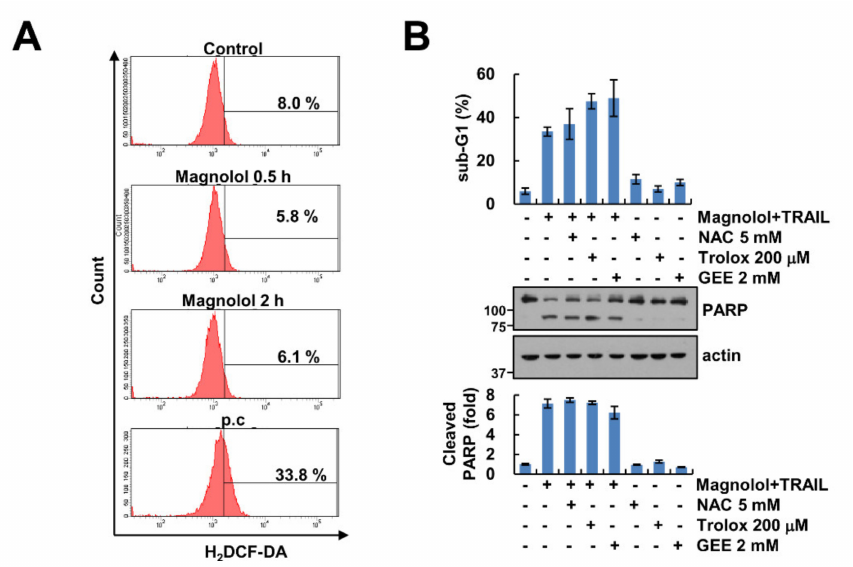
Figure 6. Involvement of ROS in magnolol plus TRAIL-induced apoptosis. ( A ) Caki-1 cells were treated with 10 µ M magnolol for 0.5 and 2 h. Thioridazine was used as positive control (p.c). Caki-1 cells were stained with H 2 DCF-DA dye. Fluorescence was detected using flow cytometry. ( B ) Caki-1 cells were treated with 10 µ M magnolol plus 50 ng / mL TRAIL in the presence or absence of 5 mM NAC, 200 µ M trolox or 2 mM GEE for 24 h. The sub-G1 population and PARP cleavage were detected using flow cytometry and Western blotting, respectively. The values in graph ( B ) represent the mean ± SD of three independent